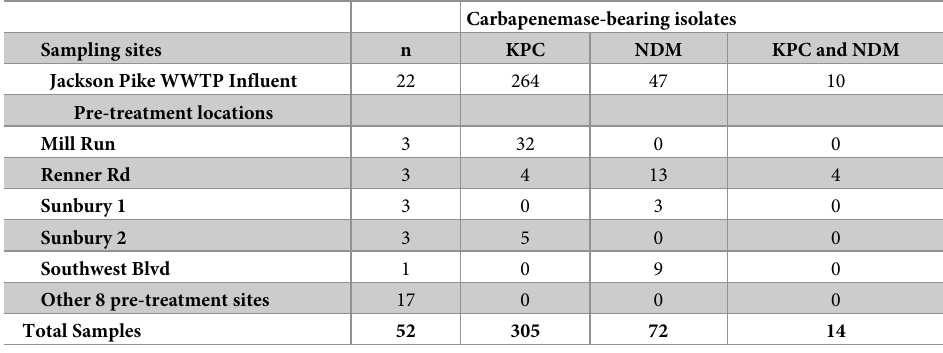
Table 2. Distribution of samples per study site.